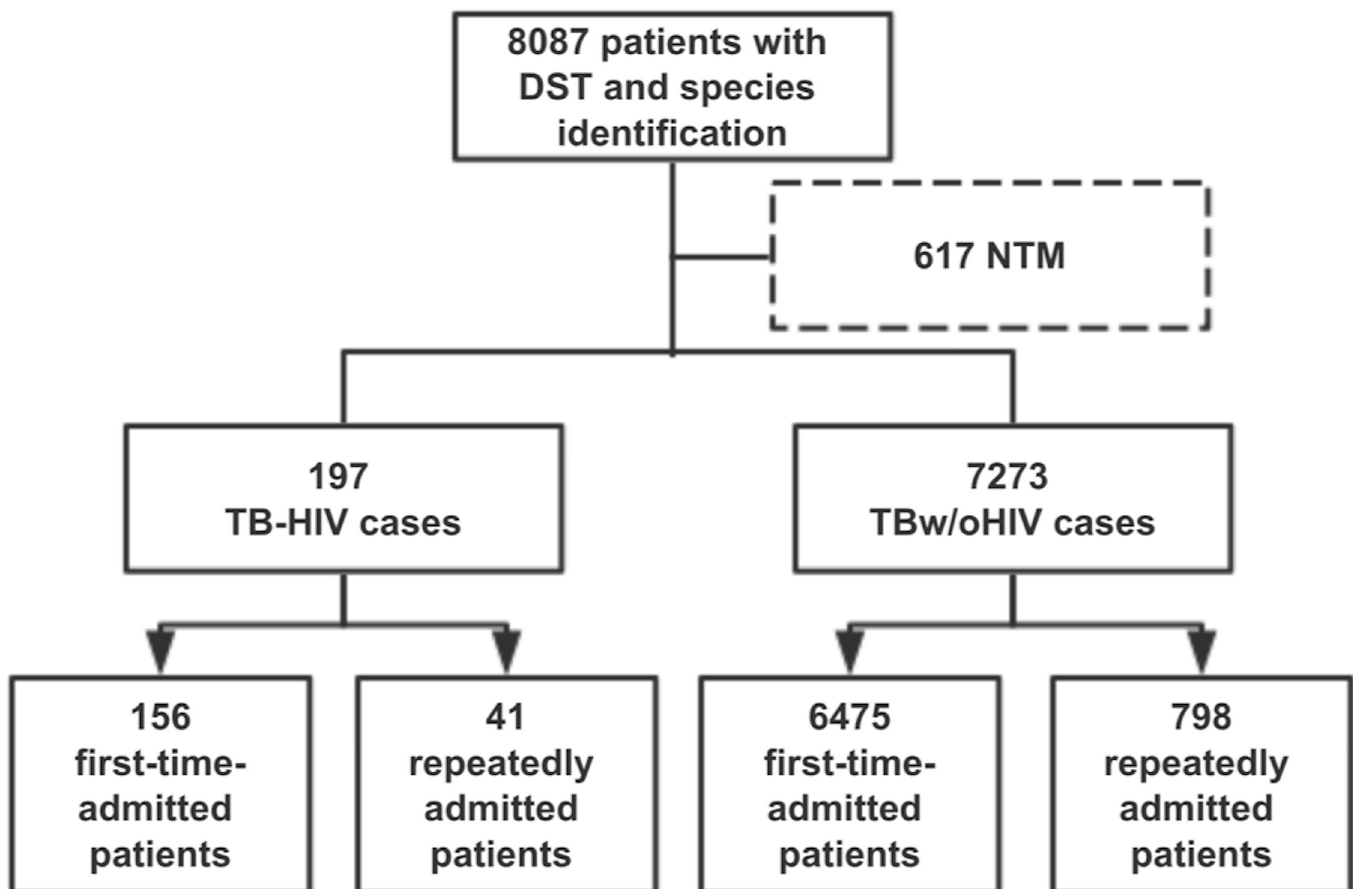
Fig 1. Flow diagram of participant enrollment. DST, drug sensitivity testing; NTM, nontuberculous mycobacteria.